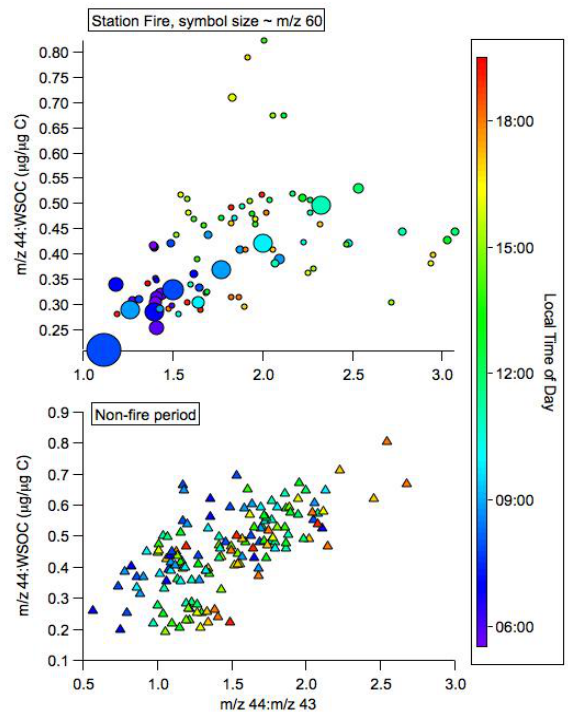
Fig. 8. Summary of the ratio m/z 44:WSOC as a function of m/z 44:43 during (top panel) and outside (bottom panel) the Station Fire period. Symbols are color-coded by time of day, and in the Station Fire panel the symbol size is proportional to the tracer for biomass burning, m/z 60 (range = 0.03–0.9 µgm − 3 )